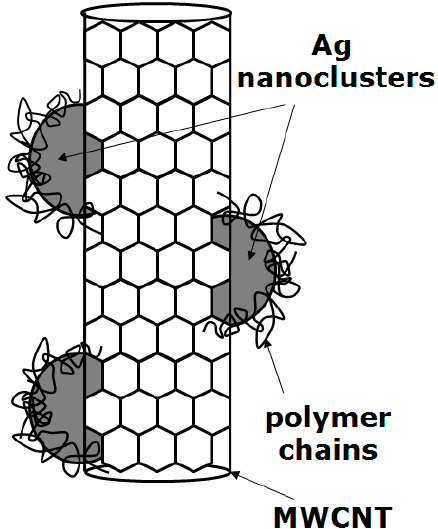
Figure 9 . Carbon nanotube/Ag